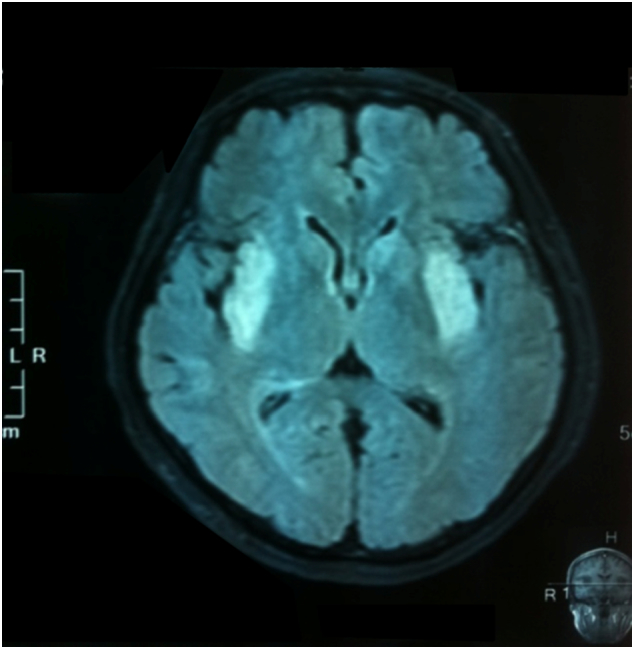
FLAIR MRI demonstrating bilateral contrast hyperintensity in the medial temporal lobes in a 44 year old male with anti-NMDA receptor encephalitis.